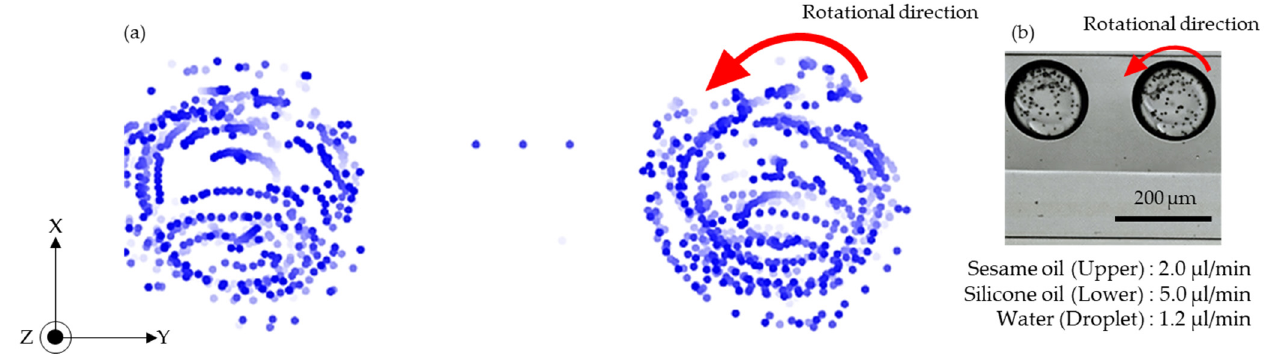
Figure 5. Trajectory of anti-clockwise rotational flow in microdroplets. ( a ) Beads plotted against time; ( b ) image of the droplet rotating anti-clockwise.